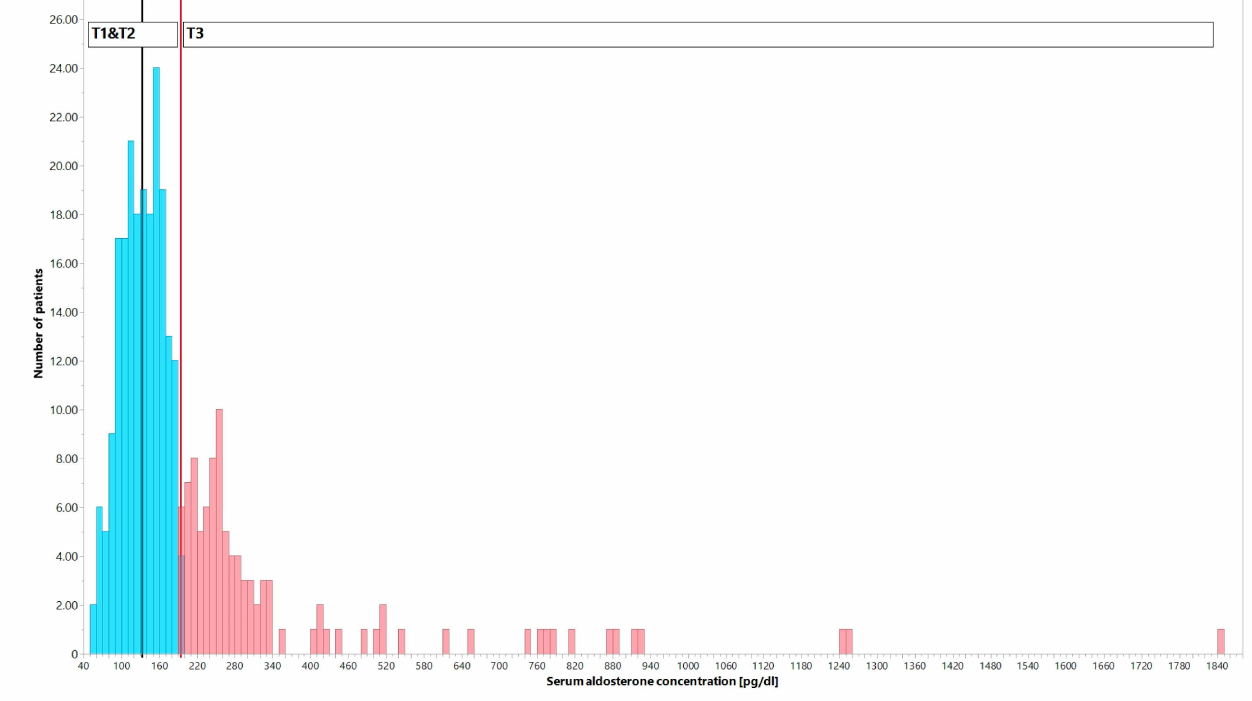
Figure 1. Distribution of the number of patients with systolic heart failure (HF) according to various serum aldosterone concentrations. Patients were divided into tertiles of serum aldosterone concentra- tions: first tertile (T1) refers to patients within the range of 56–133 pg/dL, second tertile (T2) to the range of 134–193 pg/dL, and third tertile (T3) to the range of 194–1840 pg/dL. The T1 and T2 groups were combined into a lower serum aldosterone concentration group ( n = 204, represented by blue bars) for comparison with the T3 group ( n = 102, represented by red